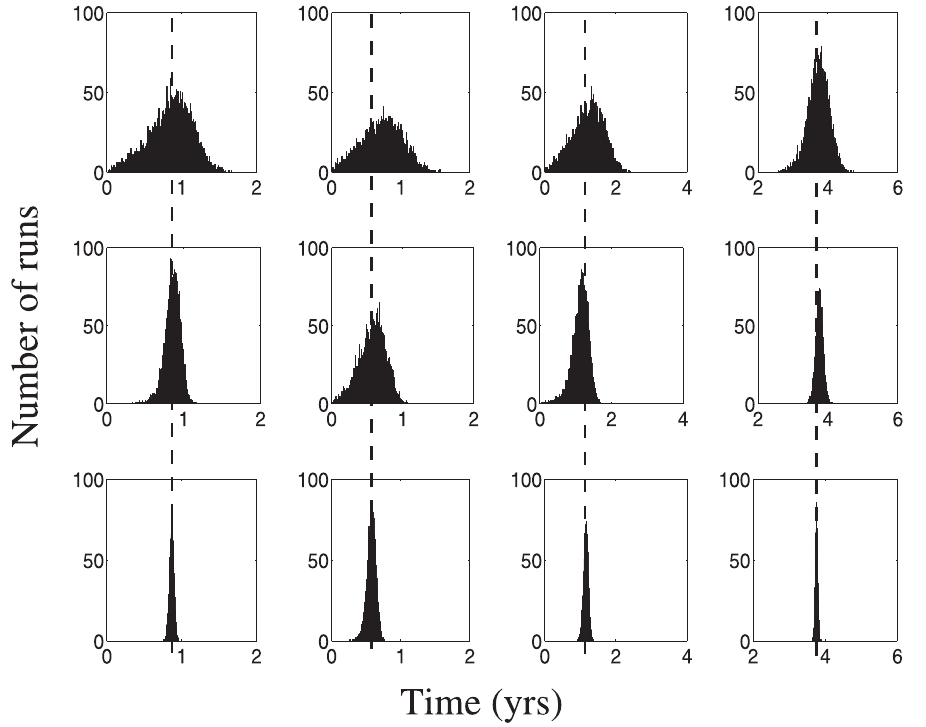
Figure 3. Regression method: the standard deviation of stage durations. All the parameters are as in figure 1.